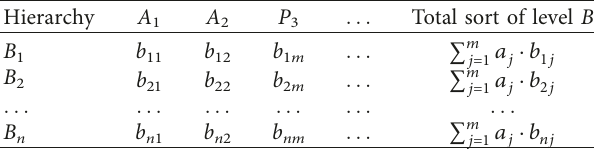
Table 5: General ranking of